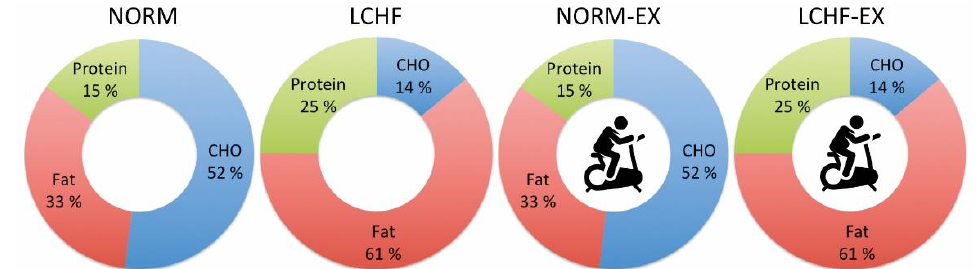
Figure 1. The E% for each macronutrient reflects the average ration planned for the 10 weeks. The carbohydrate content was increased gradually in the low-carbohydrate high-fat (LCHF) groups, with a proportional decrease in fat intake. Intervention groups. Diet only: Normal (NORM) and low-carbohydrate high-fat (LCHF) diet. Diet + exercise: Normal diet and exercise (NORM-EX) and low-carbohydrate high-fat diet and exercise (LCHF-EX). A weekly energy deficit of 4900 kcal was achieved either with calorie restriction or calorie restriction and exercise.